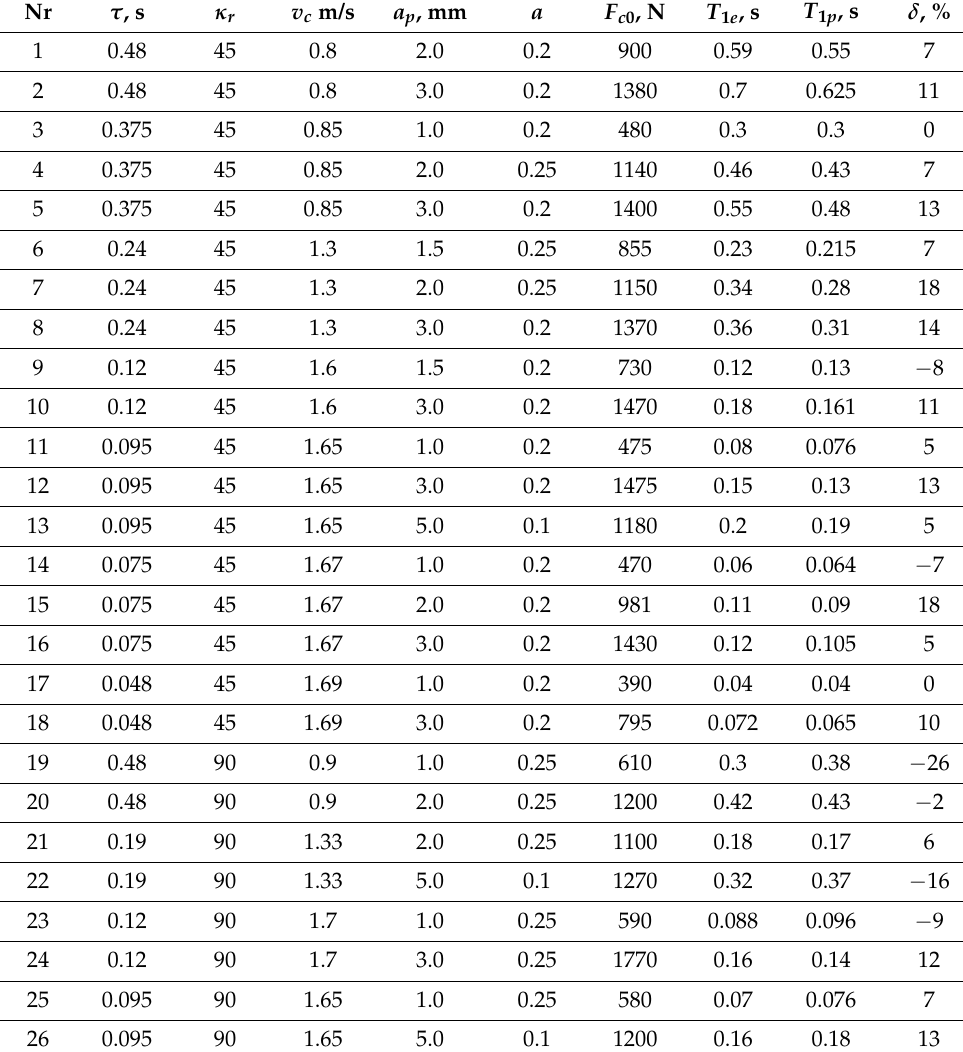
Table 1. Cutting parameters and experimental and computed time constants